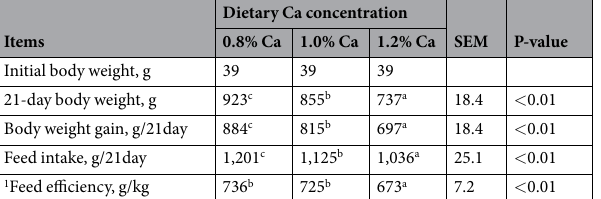
Table 1. Effects of dietary Ca concentration on the growth performance of broiler chickens during the 21-day post-hatch period. a,b,c Means with different superscript letters differ at P < 0.05. 1 Feed efficiency was calculated by dividing the body weight gain (g) by feed intake